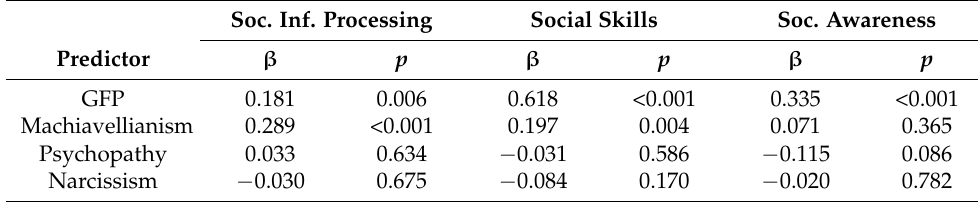
Table 6. Regression coefficients for individual